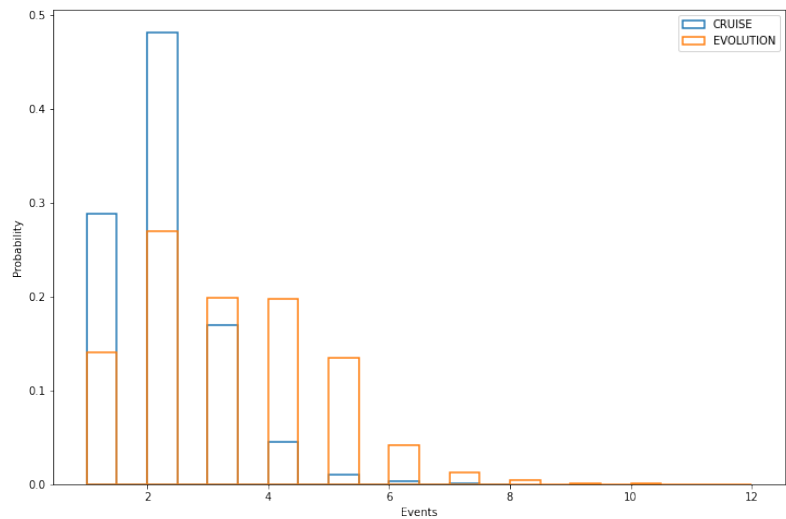
Figure 3. Distributions of the number of actions for each trend.